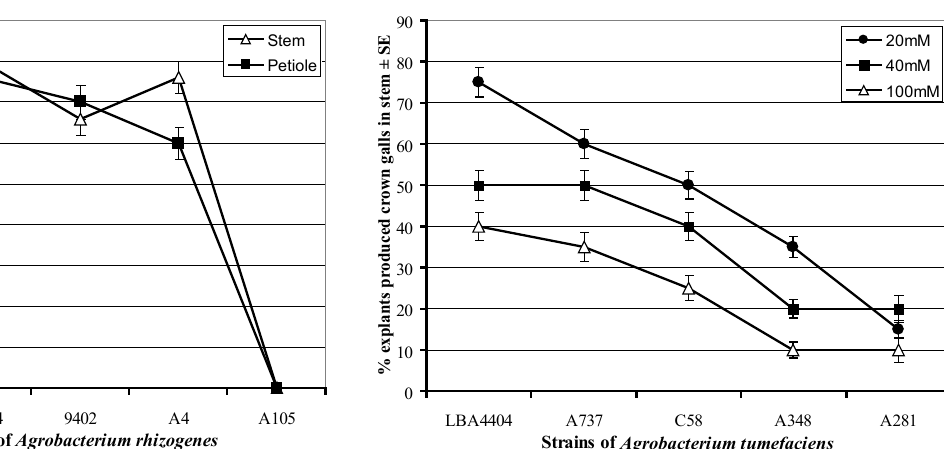
Fig. 5. Effect of dark factor on number hairy root induction in muskmelon explants